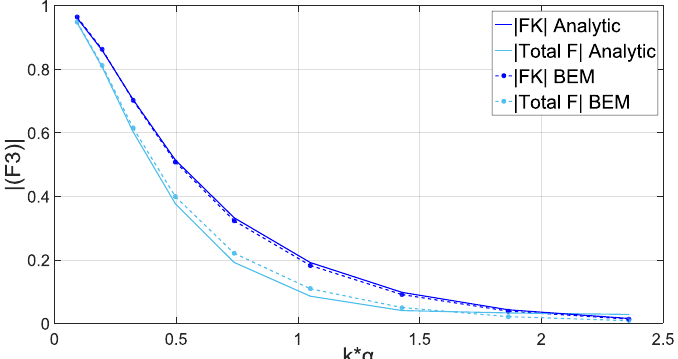
Figure 5. Non-dimensionalized cylinder hydrodynamic Froude-Krylov and total forces for various values of non-dimensionalized wavenumber (kα). Cylindrical WEC with /